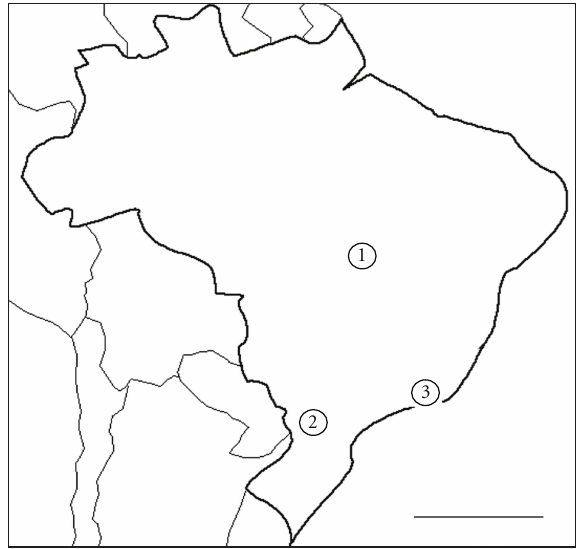
Figure 1: Sites of sample collections within Brazil. (1)-Brasilia, Distrito Federal; (2)-Palmas, Parana; (3)-Rio de Janeiro, RJ. These localities are quite di ff erent in terms of climate and vegetation. Scale bar = 800